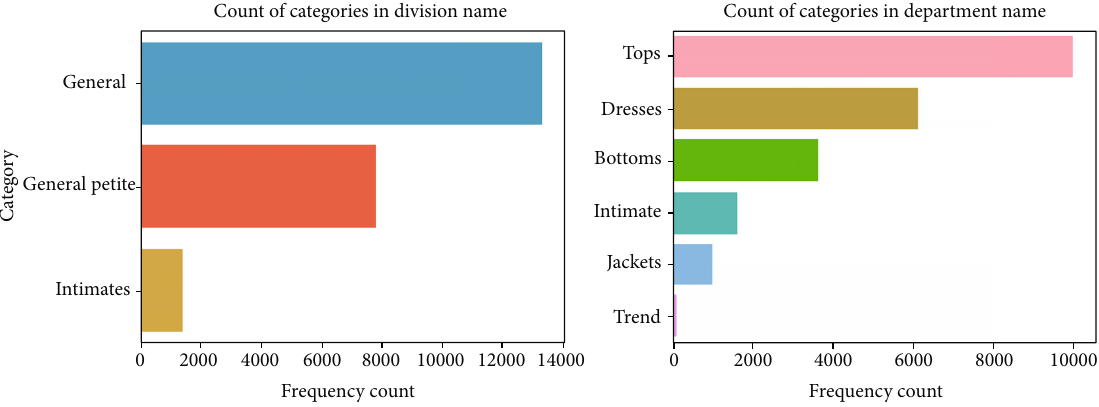
Figure 2: The frequency distribution per department and division of customer feedback.